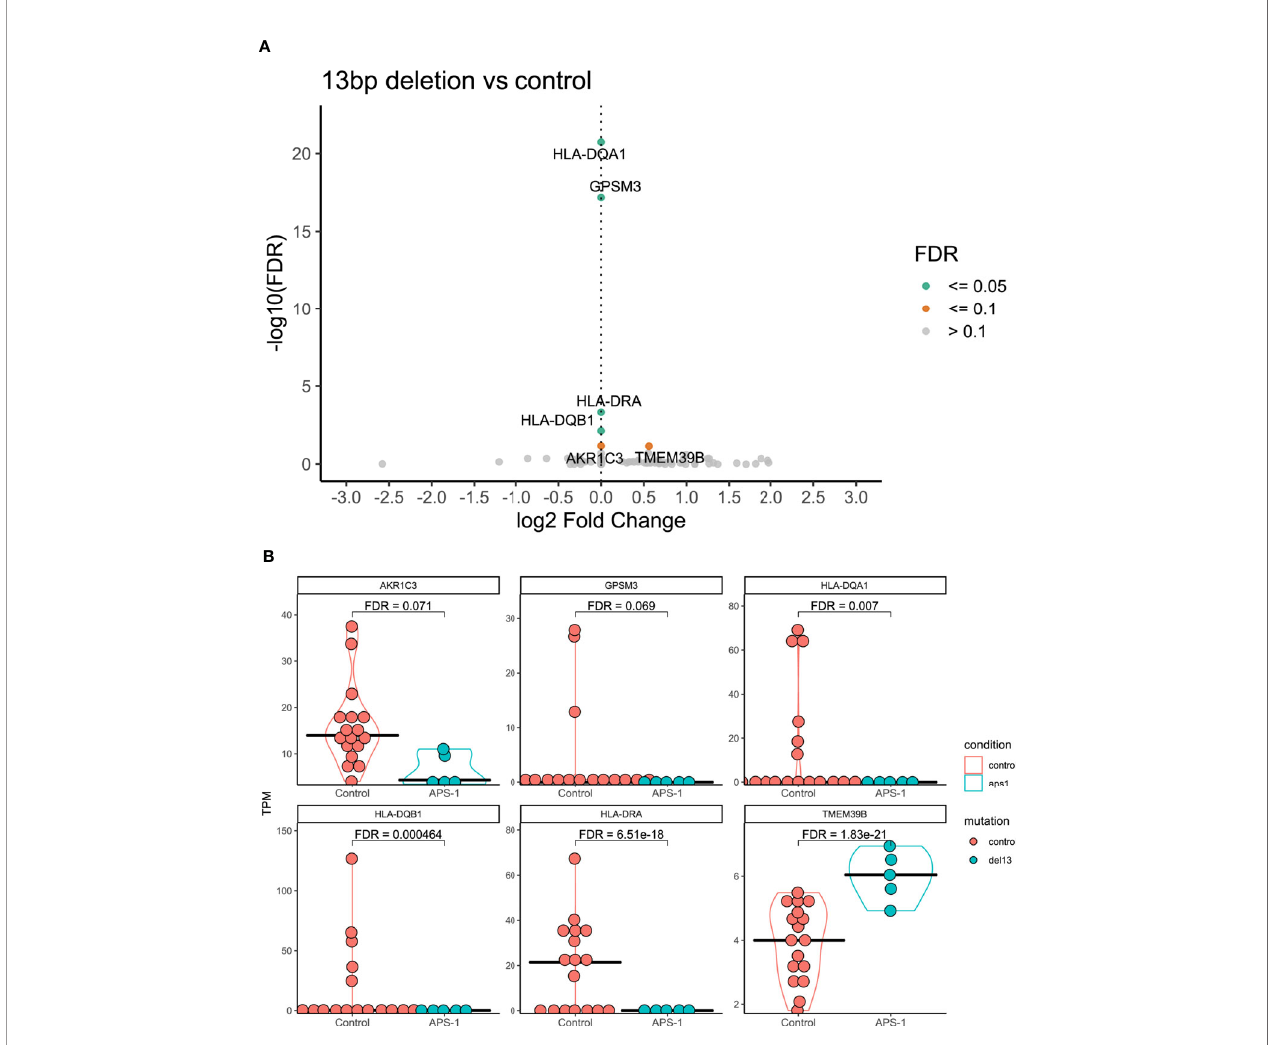
FIGURE 4 | Differential expression analysis of regulatory T cells from APS-1 patients with the 13bp deletion and controls. (A) Volcano plot of the most signi fi cantly differentially expressed genes with the magnitude of differential expression in log2 fold change and the signi fi cance level in -log10 FDR. (B) Violin plots showing the absolute expression level in transcripts per million (TPM) in all samples for the genes identi fi ed as signi fi cantly differentially expressed at a 10% FDR level in (A) FDR values on violin plots taken from differential expression analysis using DESeq2